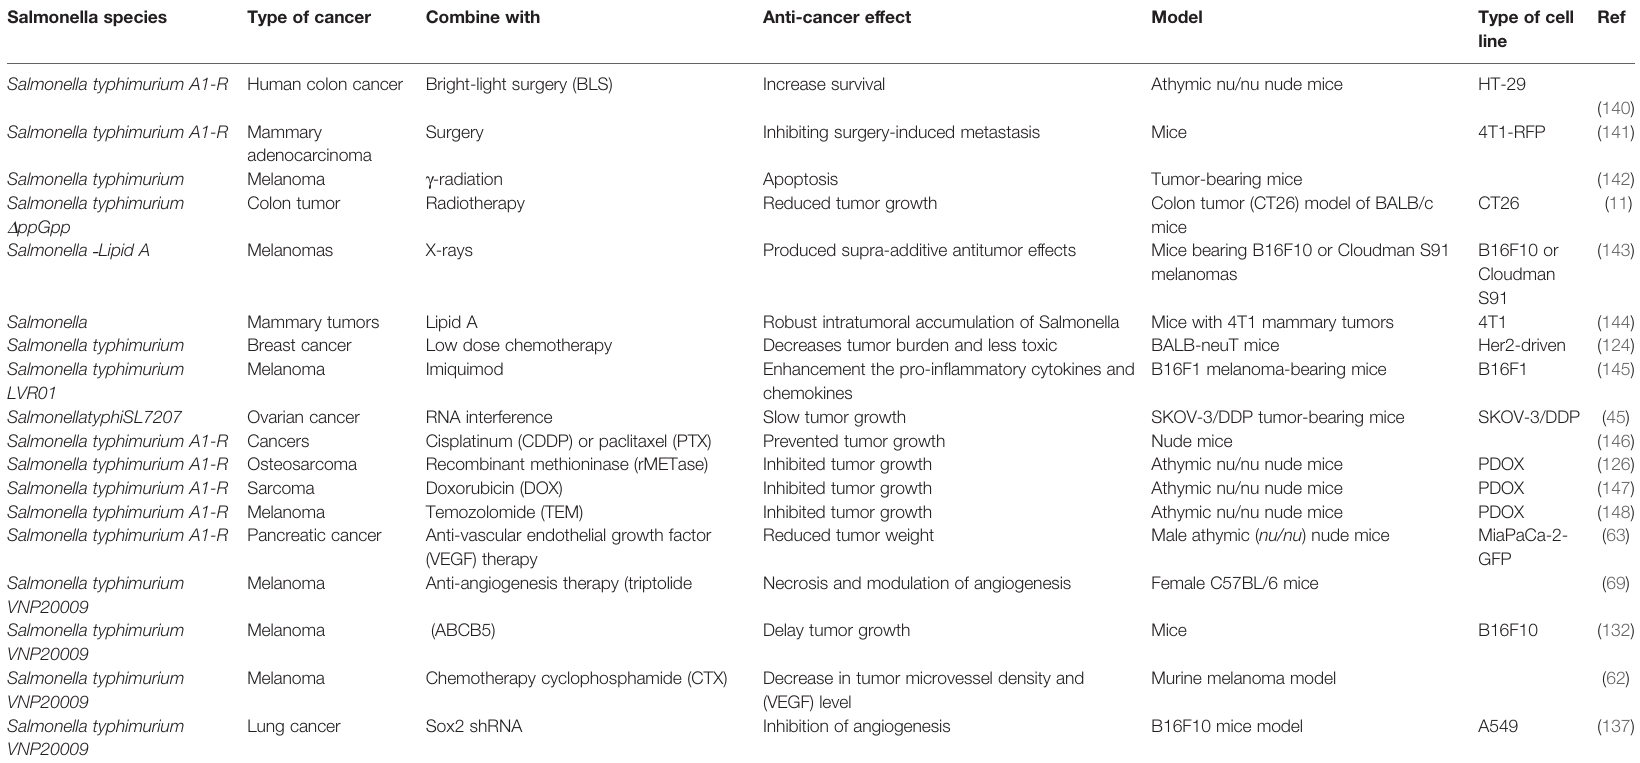
TABLE 2 | Various Salmonella strains that have been used in the combination therapy of